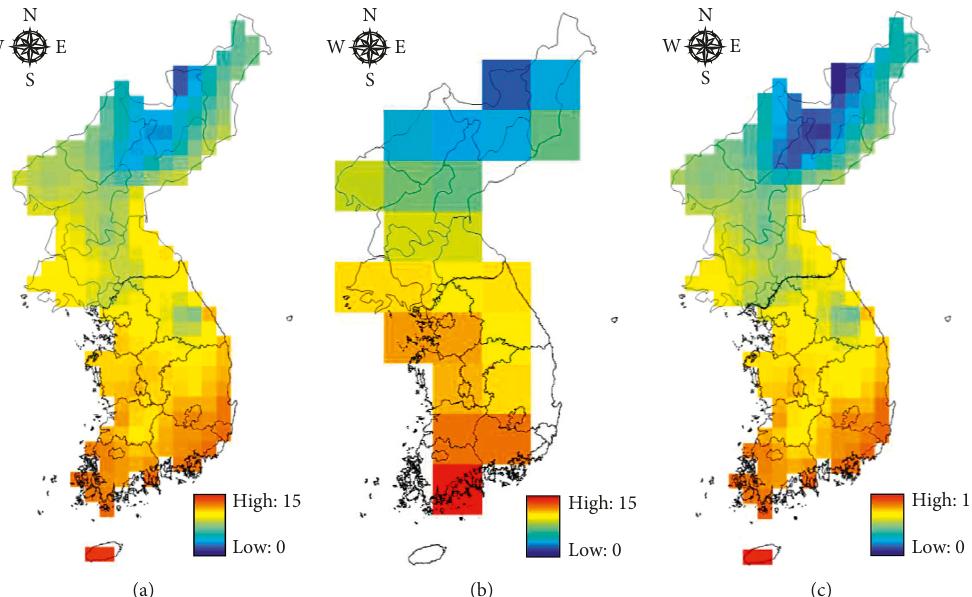
Figure 7: Observation and before/after application of the SDQDM (average temperature). (a) OBS. (b) Raw scenario. (c) Downscaled scenario.